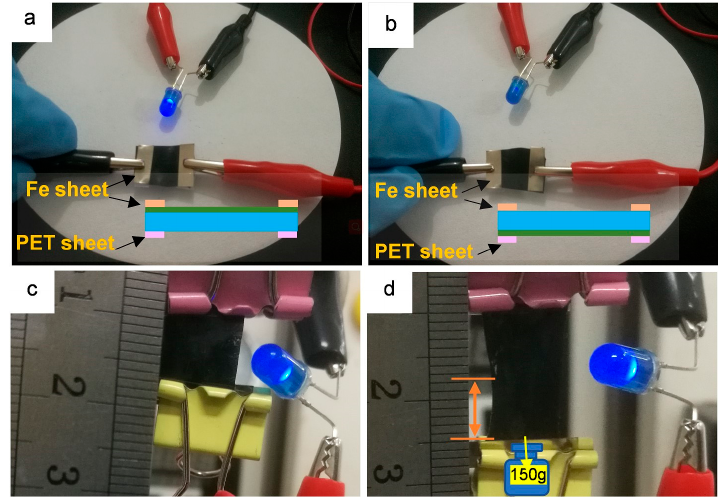
Figure 4. LED conductivity test of CNTs@PANi/SEBS- Ⅱ bilayer film: ( a ) functional layer contact with Fe sheet; ( b ) SEBS base layer contact with Fe sheet; ( c ) unstretched initial state; ( d ) about 100% strain in the stretched state.